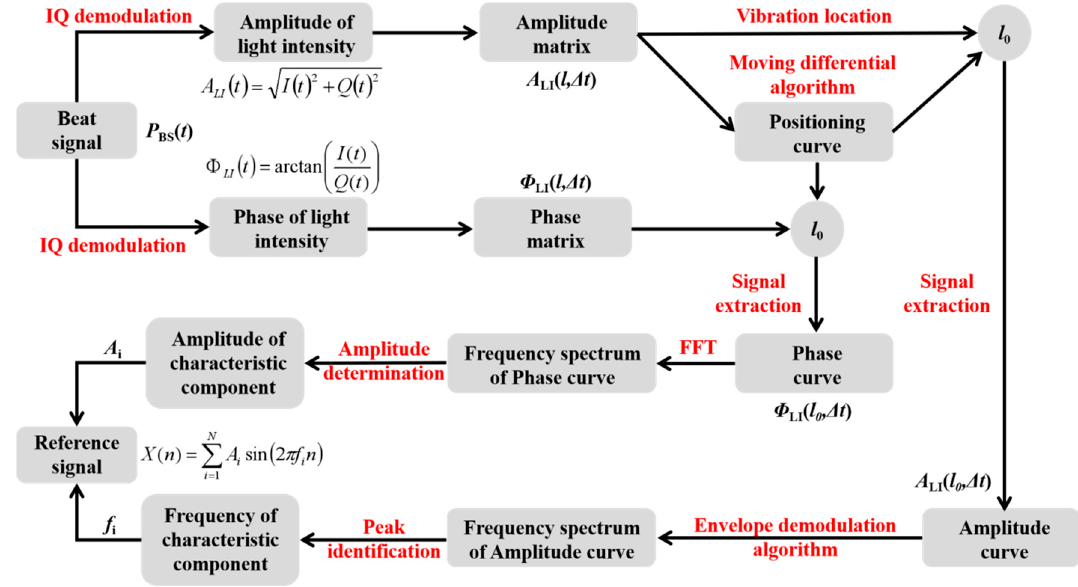
Figure 6. Schematic diagram of prior time-frequency analysis for construction of reference signal.